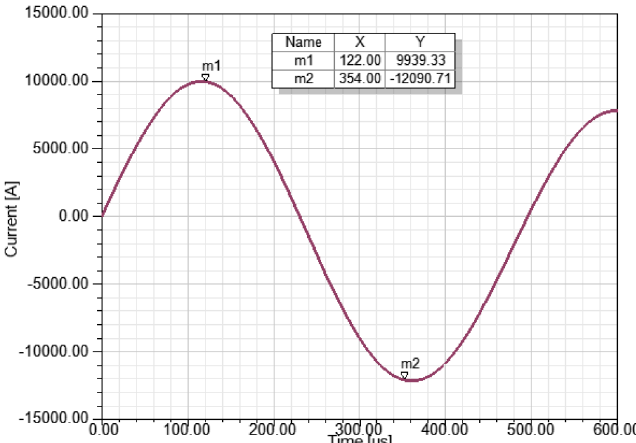
Figure 5. The secondary side current waveform.